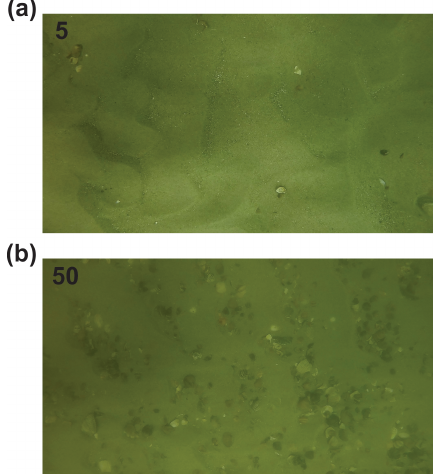
Figure 3. Stills taken from the GoPro videos (constant flow exper- iment) to show the contrast between a (a) low-density and (b) high- density treatment. Shells increasingly appear as immobile clusters at higher concentrations, as they are periodically exposed due to sand movement. The numbers represent the shell